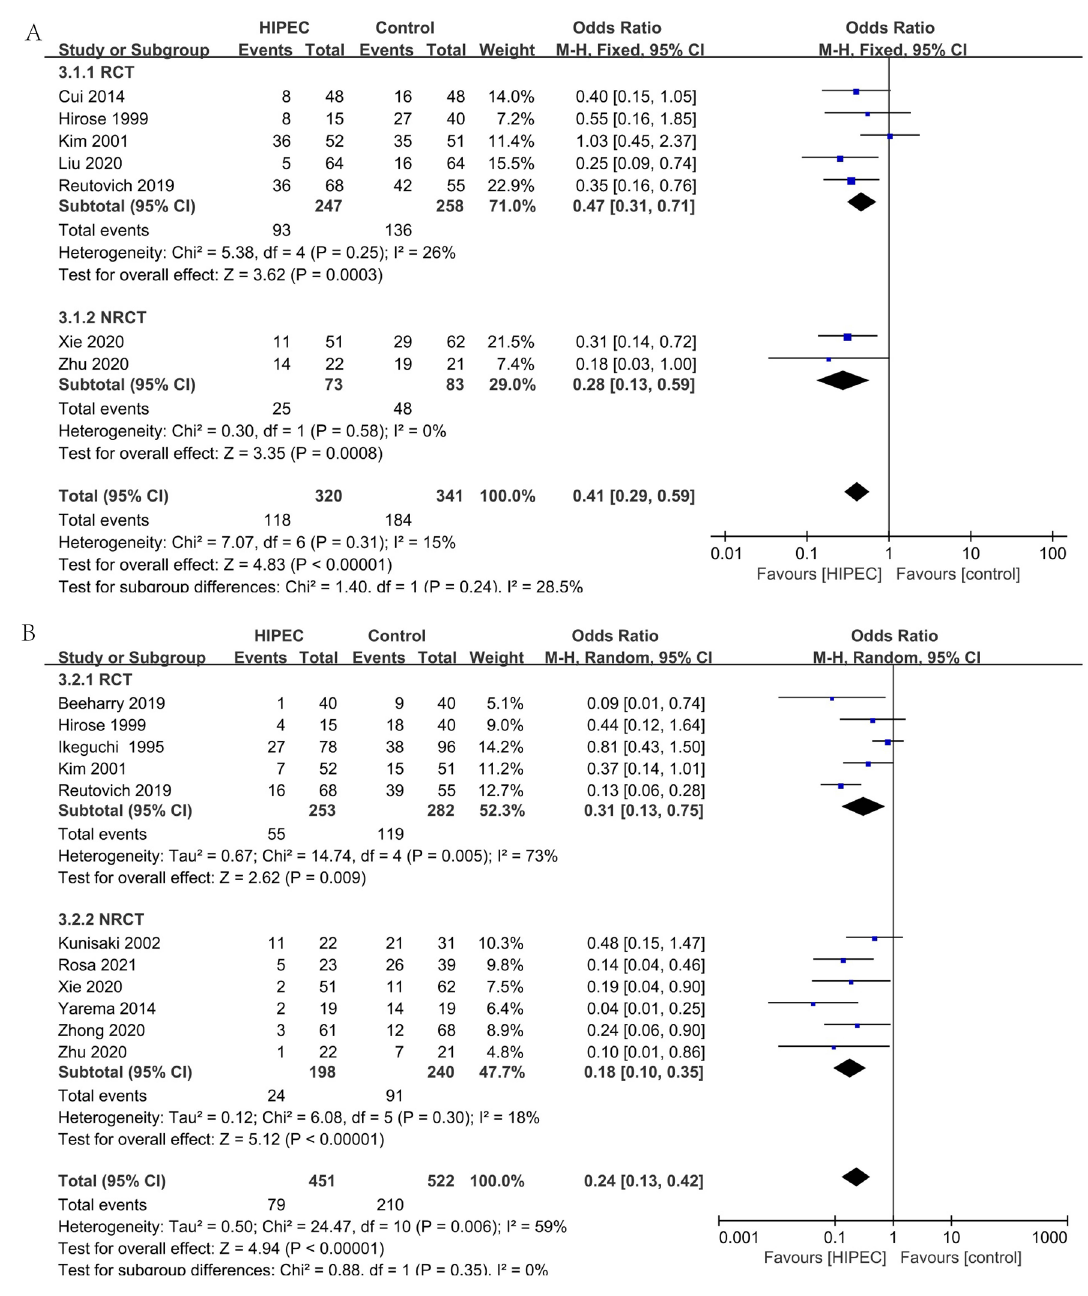
Figure 7. Overall recurrence rate ( A ), Peritoneal recurrence rate ( B